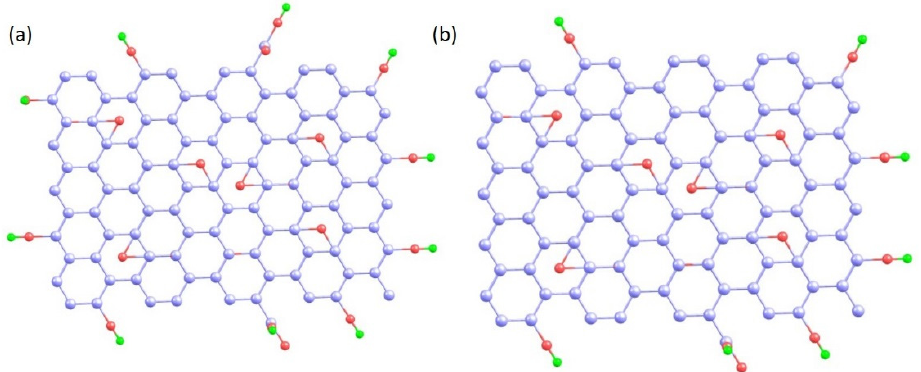
Figure 2. Structures of ( a ) graphene oxide and ( b ) reduced graphene oxide [light purple-carbon, red-oxygen and green-hydrogen].